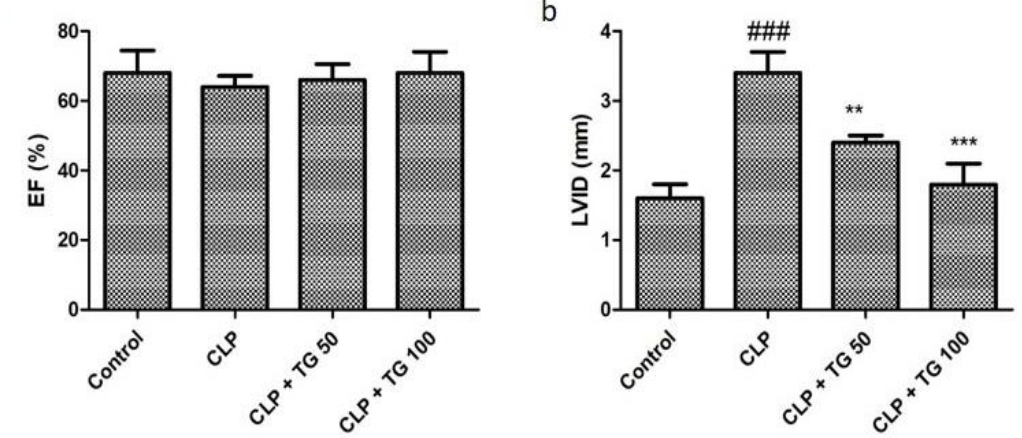
Figure 4. Cardiac function parameters. ( a ) Ejection fraction (EF) and ( b ) Left ventricular internal dimension (LVID) were measured by echocardiography. LVID was significantly increased whereas effect on EF was non-significant in CLP rats. TG (50 and 100 mg/kg) reversed the change in LVID in dose dependent manner. Values represented as means ± SD and n = 12/group. One-way analysis of variance (ANOVA), followed by Tukey’s test were used for statically analysis. Where ### p < 0.001 compared to control group, whereas ** p < 0.01 and *** p < 0.001 when compared with CLP group animals.